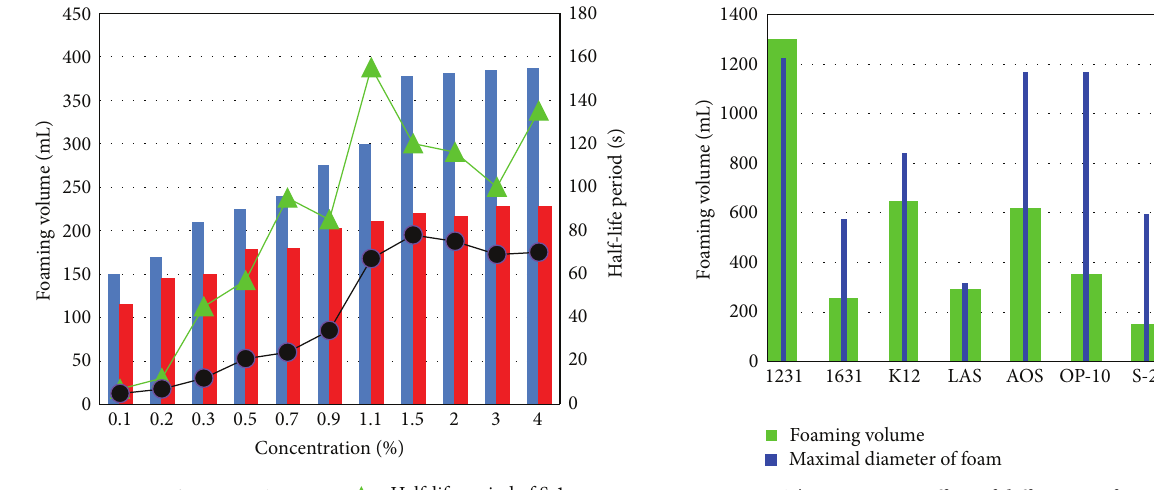
Figure 4: The synergistic effect of different surfactants with S-1.